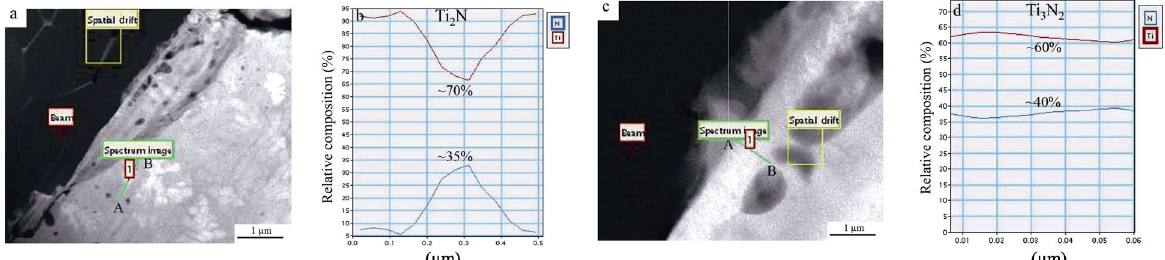
Fig. 5 (a, c) STEM − HAADF quantitative mapping for heat treated Si 3 N 4 –Ti sample, (b) Ti/N relative composition given by quantitative line analysis along the green line between A and B corresponding to Ti 2 N phase, and (d) Ti/N relative composition given by quantitative line analysis along the green line between A and B corresponding to Ti 3 N 2